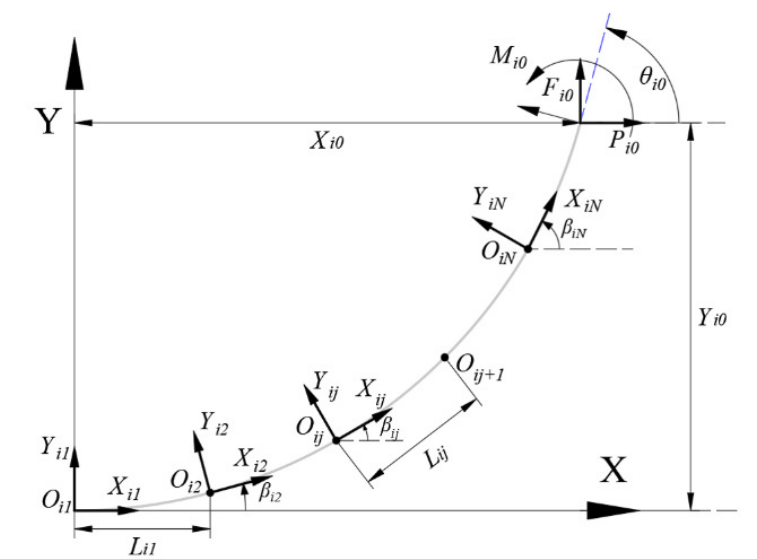
Figure 5. Discretization of circular beam at its undeformed